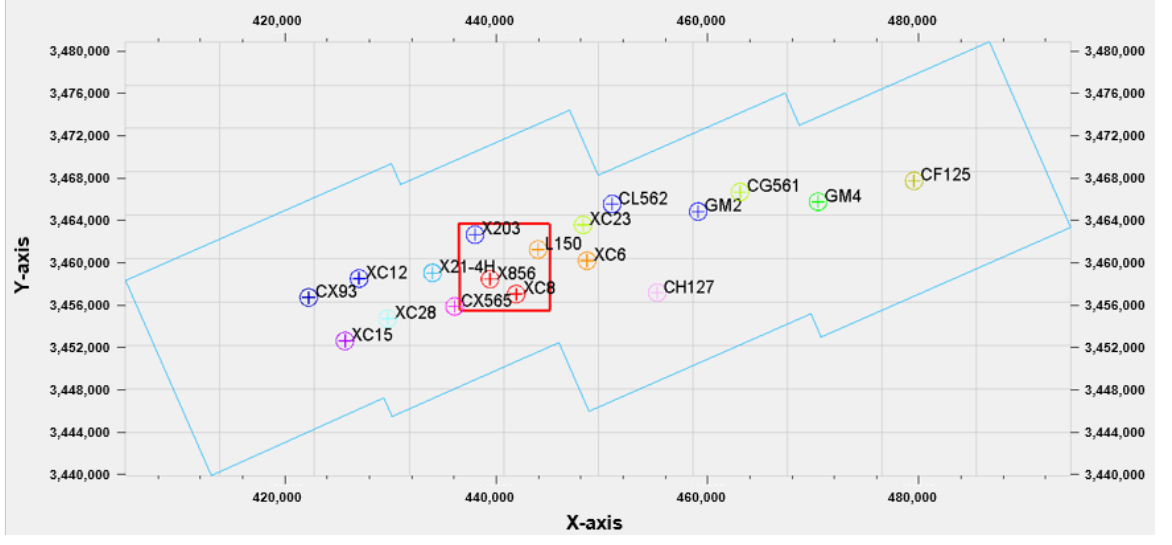
Figure 9. Drilling distribution map of the actual working area and the location of the inversion block.